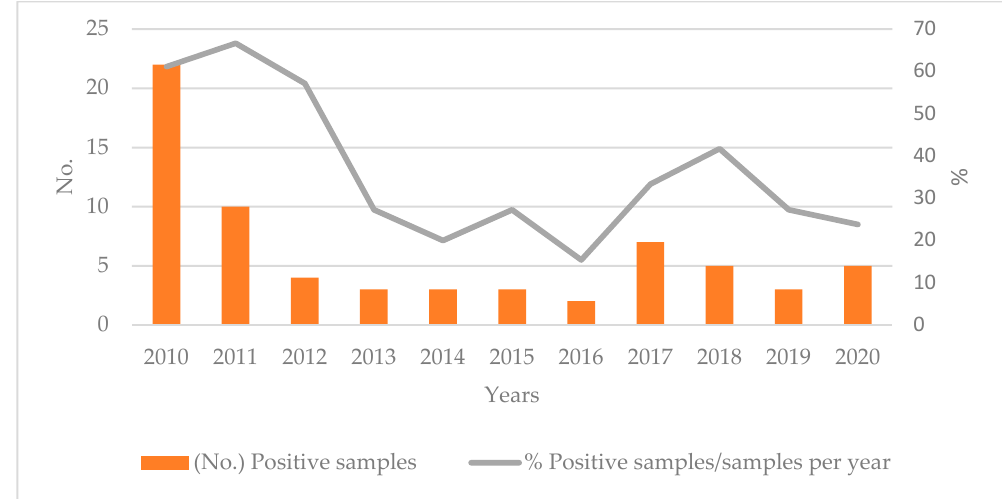
Figure 2. Trend of the number of positive samples detected during the years considered shown both as absolute numbers (orange bars referred to the left scale) and as a trend of the normalized data (grey line referred to the right scale).